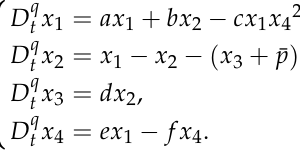
Figure 12. Symmetric coexistence chaotic attractors of system (15). (Red is ( 0.1,0.1,0.1,0.1 ) and blue is ( 0.1,0.1,0.1,0.1 ) ). − −